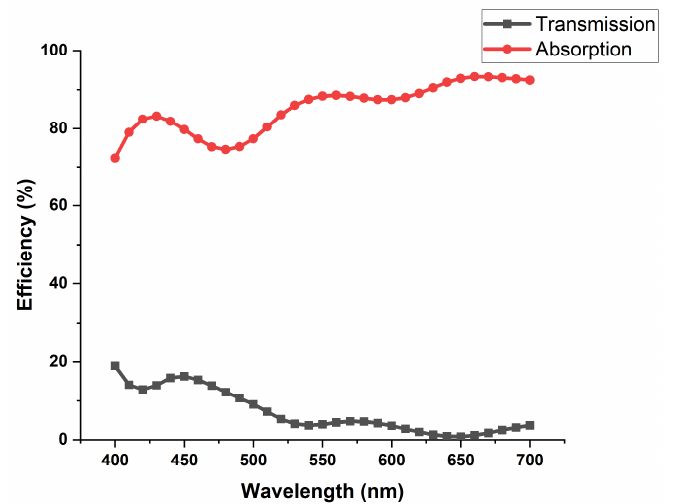
Figure 3. Black and red lines are the transmission and absorption spectra of our LHDCP under RHP incident light.